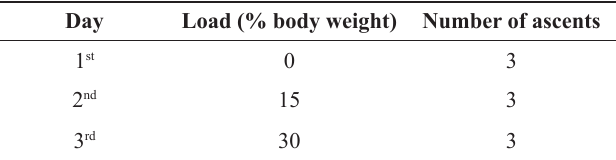
Table 2: Adaptation to the resistance training protocol Day Load (% body weight)